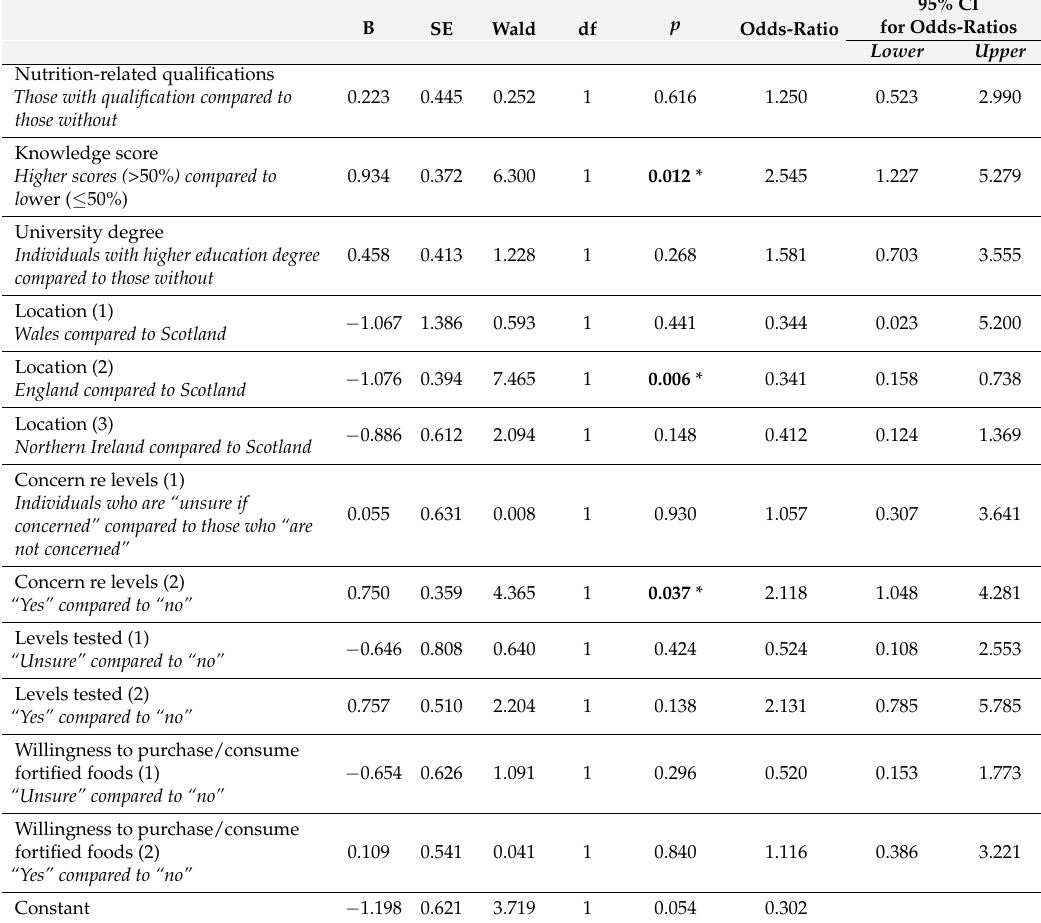
95% CI for Odds-Ratios Lower Upper